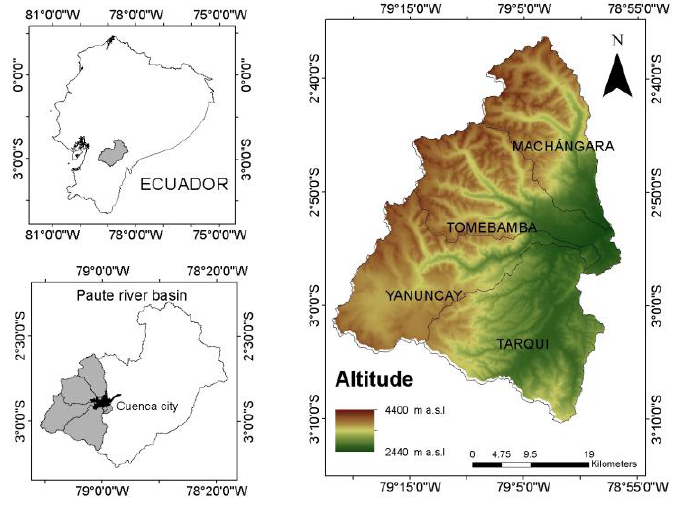
Figure 1. Study area location.